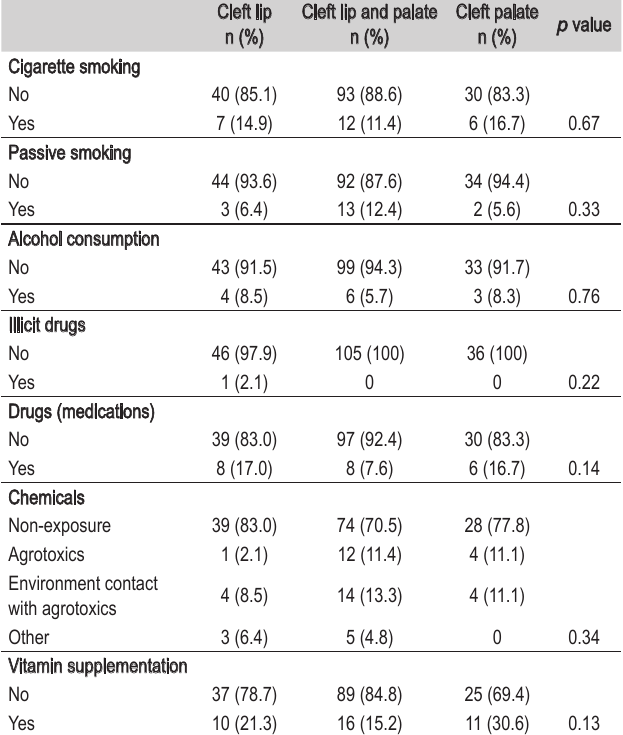
Table 3 - Frequency of maternal exposure to environment factors during the first trimester of pregnancy, according to patients with nonsyndromic cleft lip and/or palate.